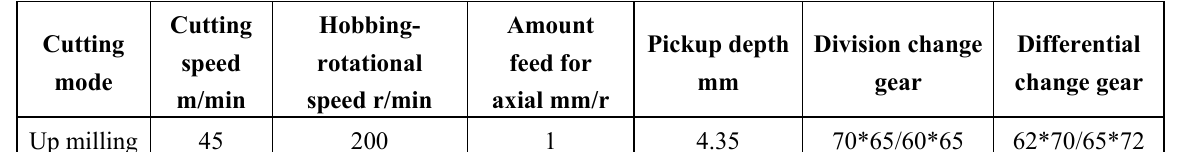
Table 10. Optimization result of cutting parameter.